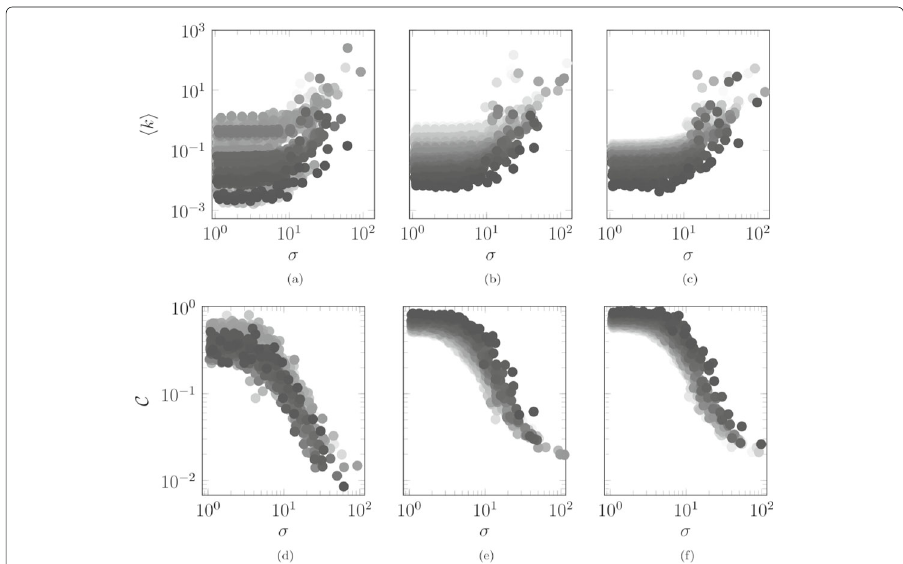
Fig. 4 Influence of the location radius on the agents’ average degree a - c and clustering coefficient d - f , for three different parameter settings. Average degree and cluster coefficient are numerically estimated by tracking every agent in the system. Darker circles represent agents assigned to more peripheral locations, while brighter ones indicates agents belonging to more central locations. We set: a - d p = 0.1 and α = 0, b - e p = 0.4 and α = 0.2, and c - f p = 0.8 and α = 0.4. Agents are initially inside their base location and contacts are recorded after 100 steps to allow the agents to reach a steady-state configuration. Other parameter values are L = 100, N = 10,000, D = 10 9 , (cid:6) min = 100, (cid:6) max = 10,000, σ min = 1, σ max = 1,000, v = 500, c = 4 · 10 − 4 , ω = 2.4, γ = 2.1, and T =